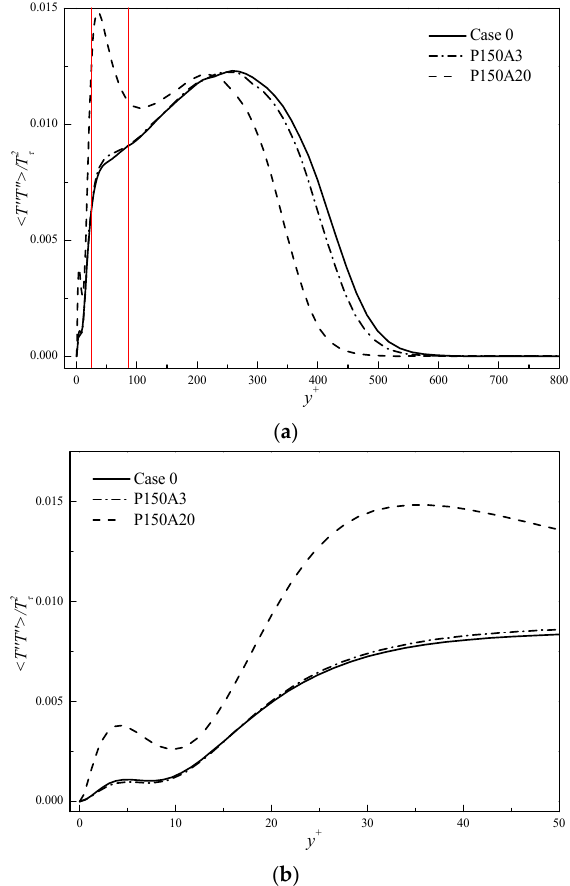
Figure 13. Turbulent temperature fluctuation intensity ( a ) and zoomed in near wall region ( b ) at x = 40.775.